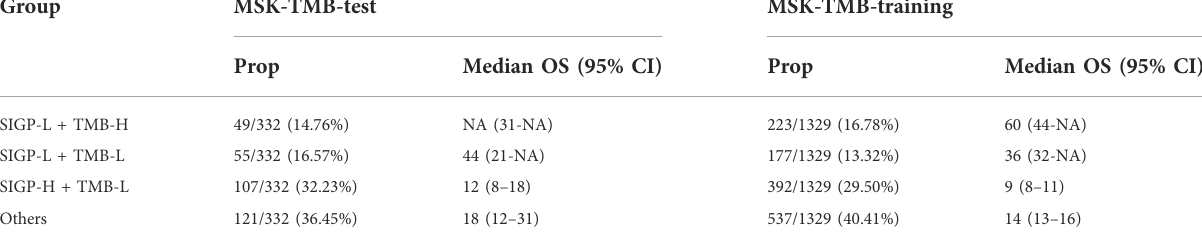
TABLE 1 Proportions (Prop.) and median survival of SIGP-L + TMB-H, SIGP-L + TMB-L, SIGP-H + TMB-L and Others in the MSK-TMB-test cohort and the MSK-TMB-training cohort.